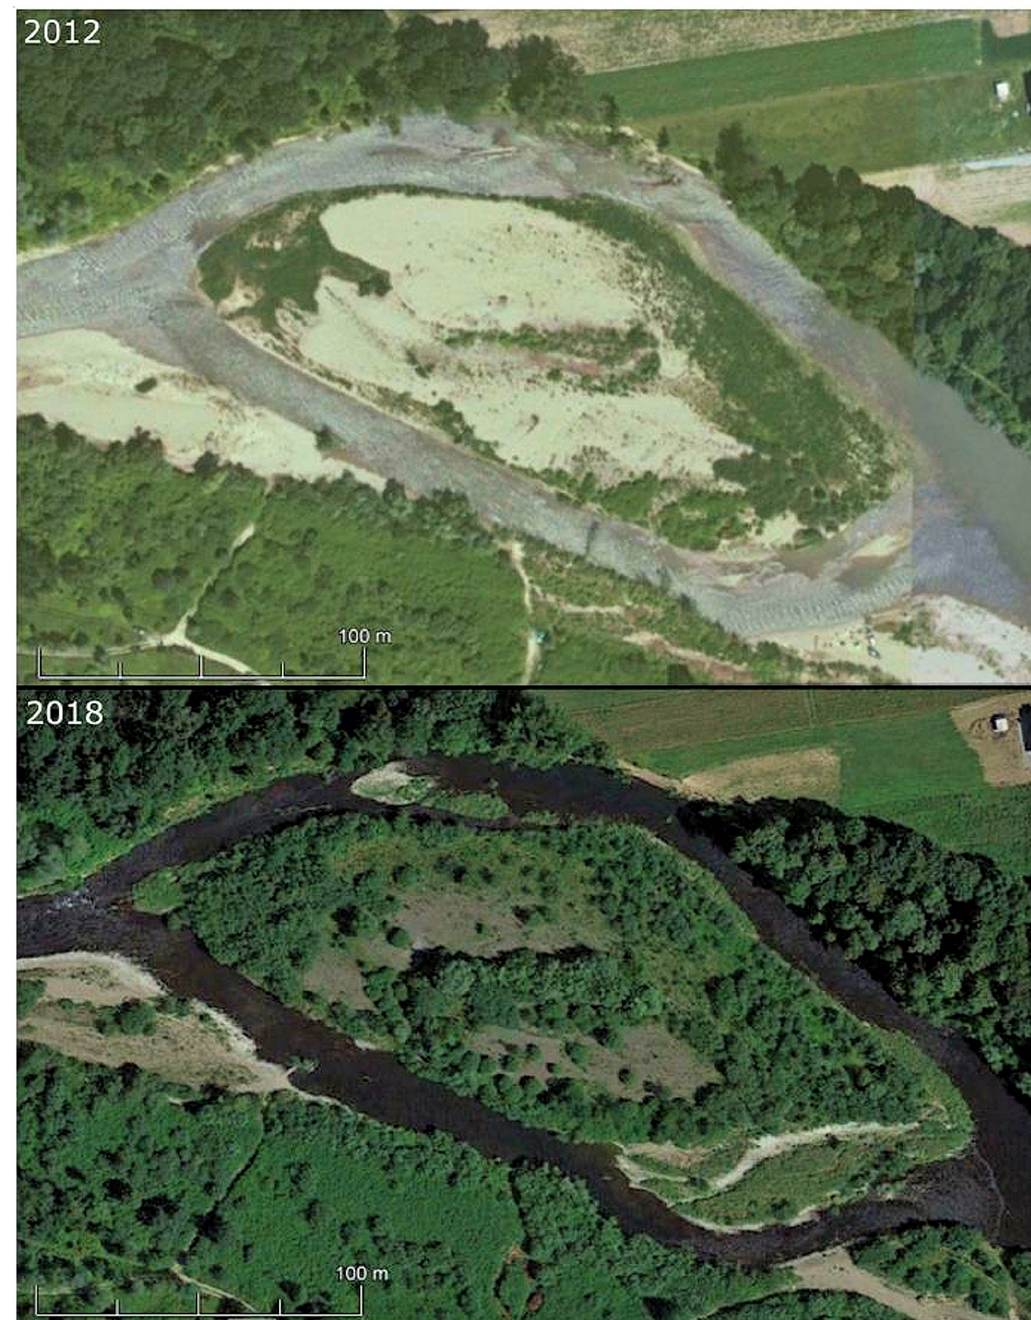
Fig. 8. Satellite images of the Skawa river near Jaroszewice in 2012 and 2018 (Google Earth, downloaded on August 16,